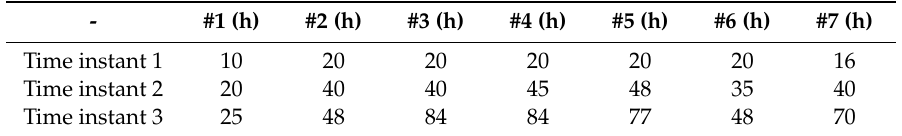
Table 2. Used time instants expressed in test hours to predict the RUL for each of the connectors under